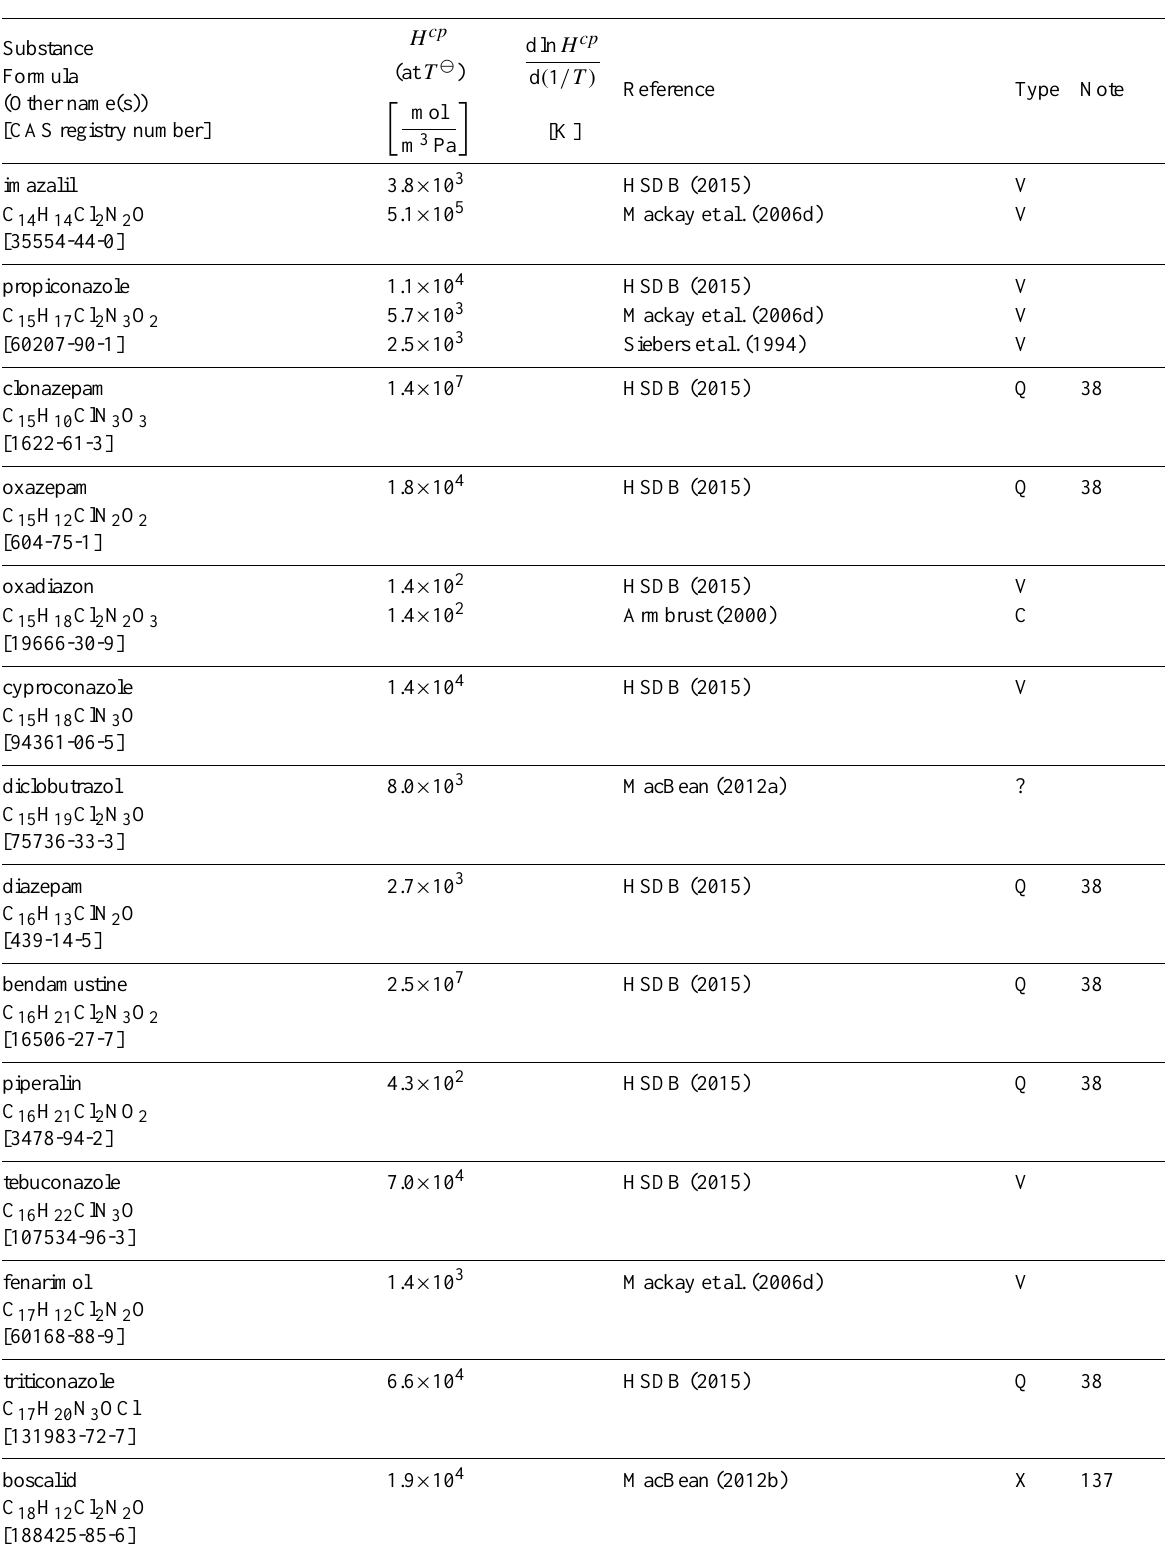
Table 6: Henry’s law constants for water as solvent